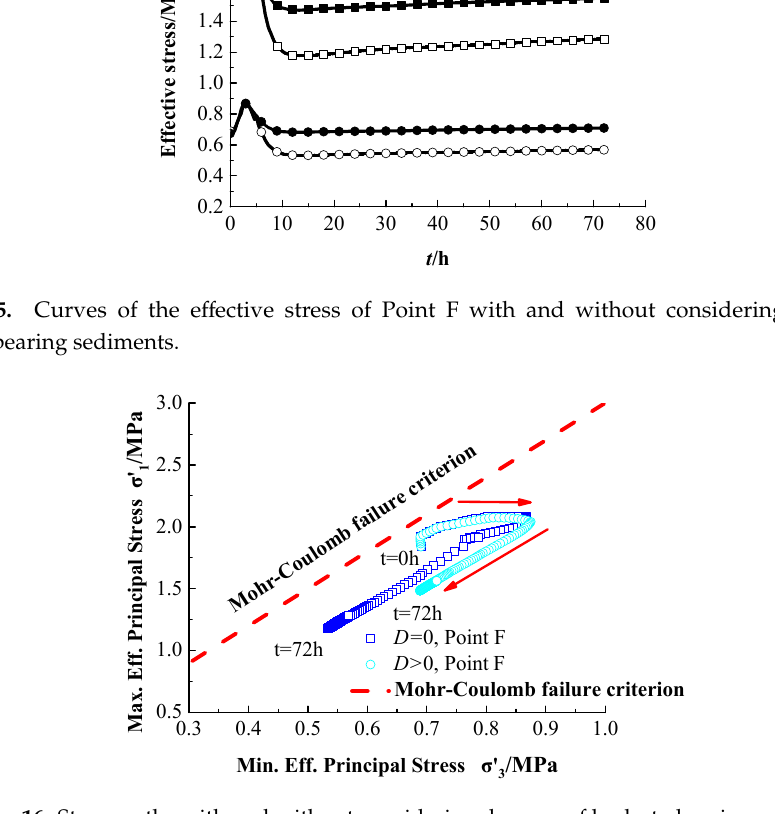
Figure 16. Stress paths with and without considering damage of hydrate-bearing sediments. Based on the Mohr–Coulomb failure criterion, the reservoir stability coefficient F b was defined [30]. When F b ≤ 1, the reservoir is unstable, and the smaller F b is, the worse the reservoir stability is. When F b > 1, the reservoir is in a stable state.